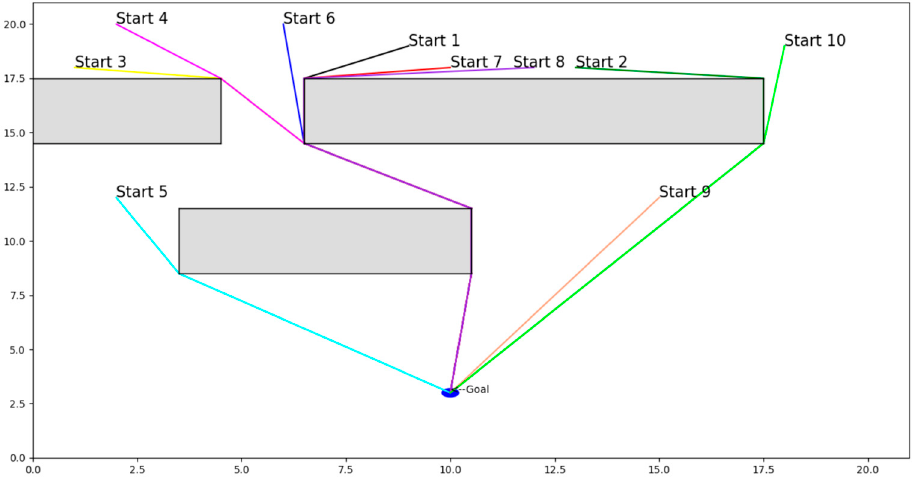
Figure 12. Typical sample optimal trajectories for data collection.